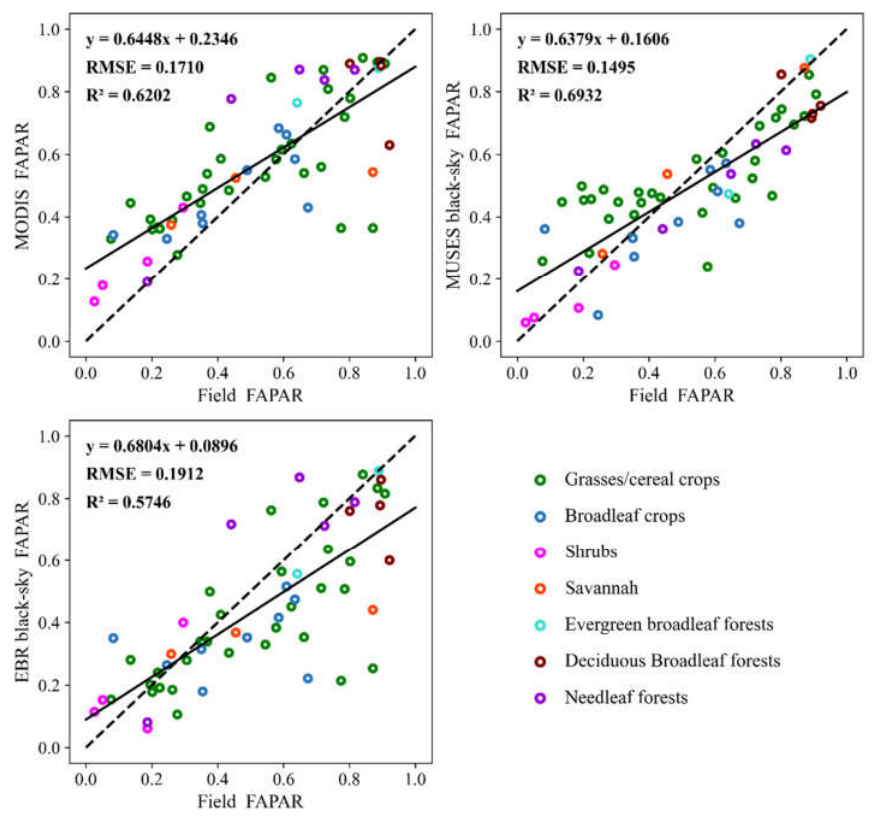
Figure 7. Scatterplots of the MODIS, MUSES and EBR black-sky FAPAR values versus the FAPAR values derived from the high-resolution FAPAR reference maps.